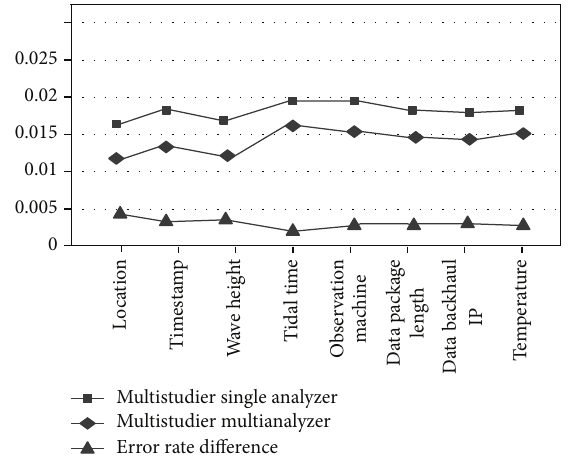
Figure 7: Comparative analysis of multilearner strategies.